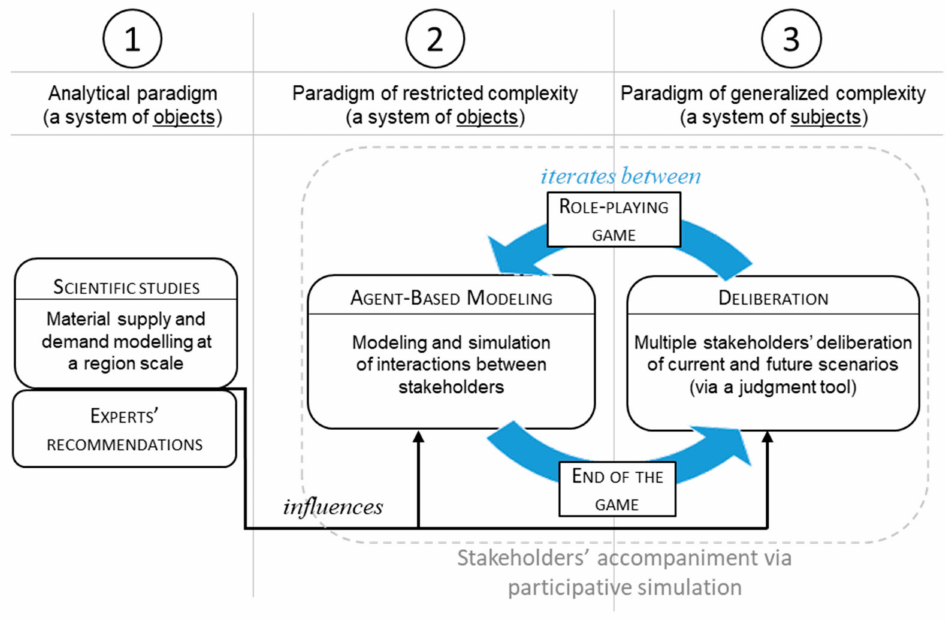
Figure 4. The three levels of the complexity paradigm of a system, adopted by this paper to deal with the complexity of the PRPGD. The ACE modelling approach is in Paradigm 2. Source: the three paradigms’ basic scheme is drawn from